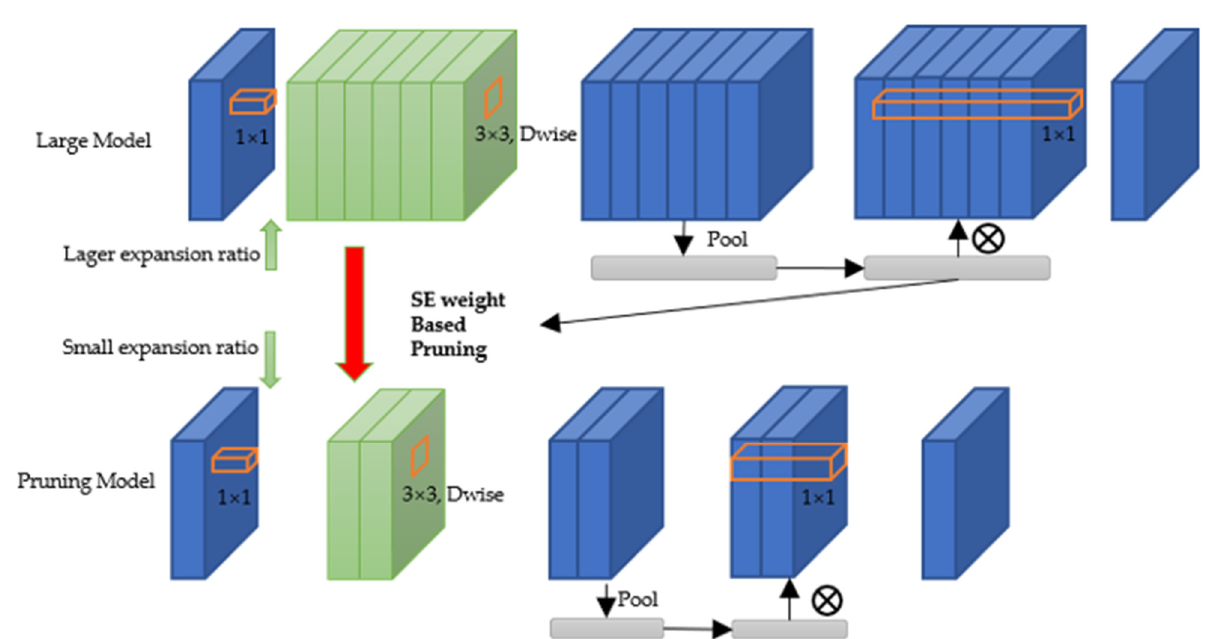
Figure 1. The proposed model pruning method is based on SE (squeeze-and-excitation) optimization weight. Build a model with higher accuracy by setting a larger expansion ratio (above model). Calculate the SE weight of the corresponding part of the training data set, and score the depthwise convolution kernel. Cut the corresponding depthwise convolution kernel to get a smaller model (below model). The accuracy of the model remains at a similar level.